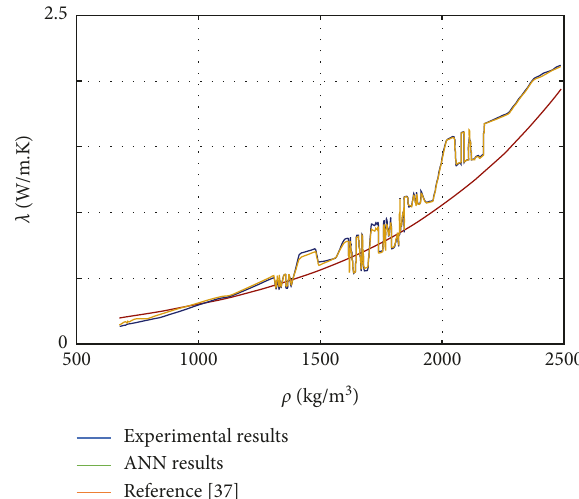
Figure 10: The comparison of the experimental, ANN, and a correlation to Reference [37] results for thermal